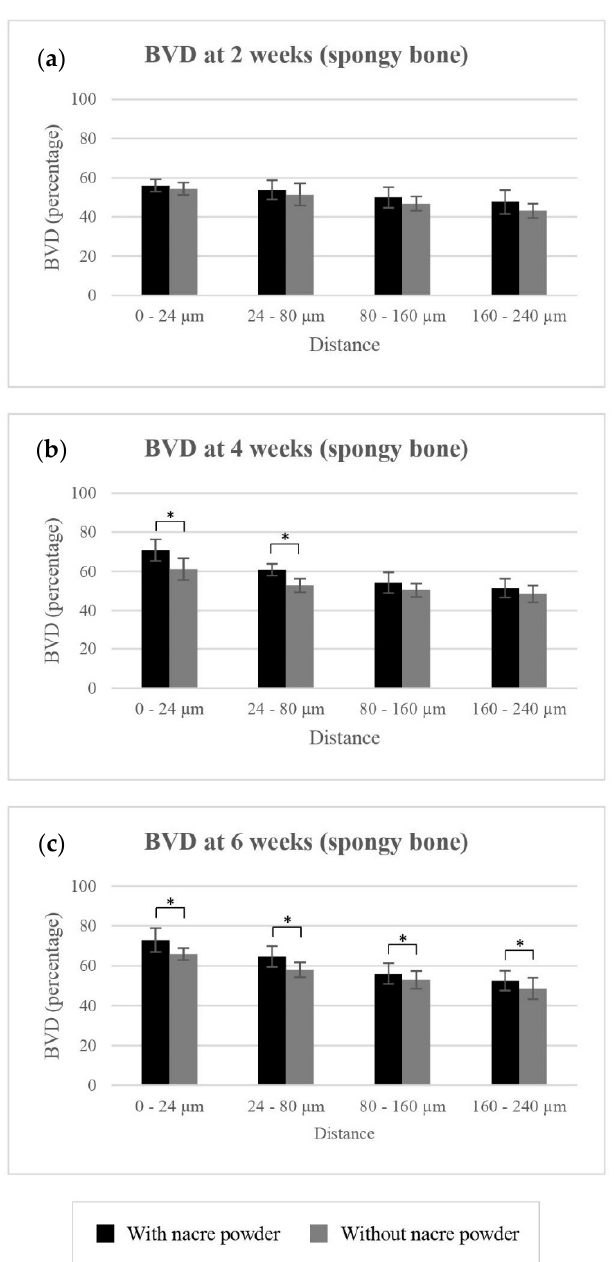
Figure 4. The clustered columns showing mean BVD in percentage of implantations with or without nacre powder, using XiVE ® dental implants in spongy bone at distances of 0–24 µ m, 24–80 µ m, 80–160 µ m, and 160–240 µ m from the implant surface. ( a ) At week 2. ( b ) At week 4. ( c ) At week 6. * indicates difference at significance level 0.05.